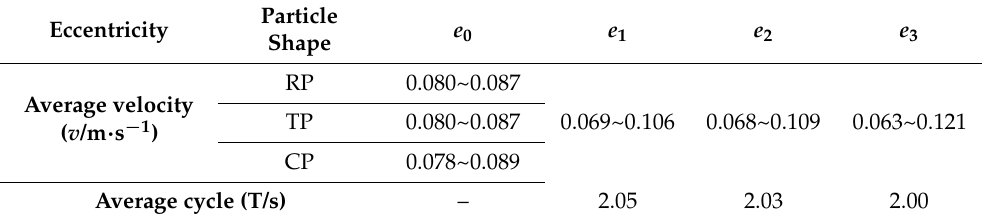
Table 5. The average velocity and the average period of particulate matter under different working conditions at 15